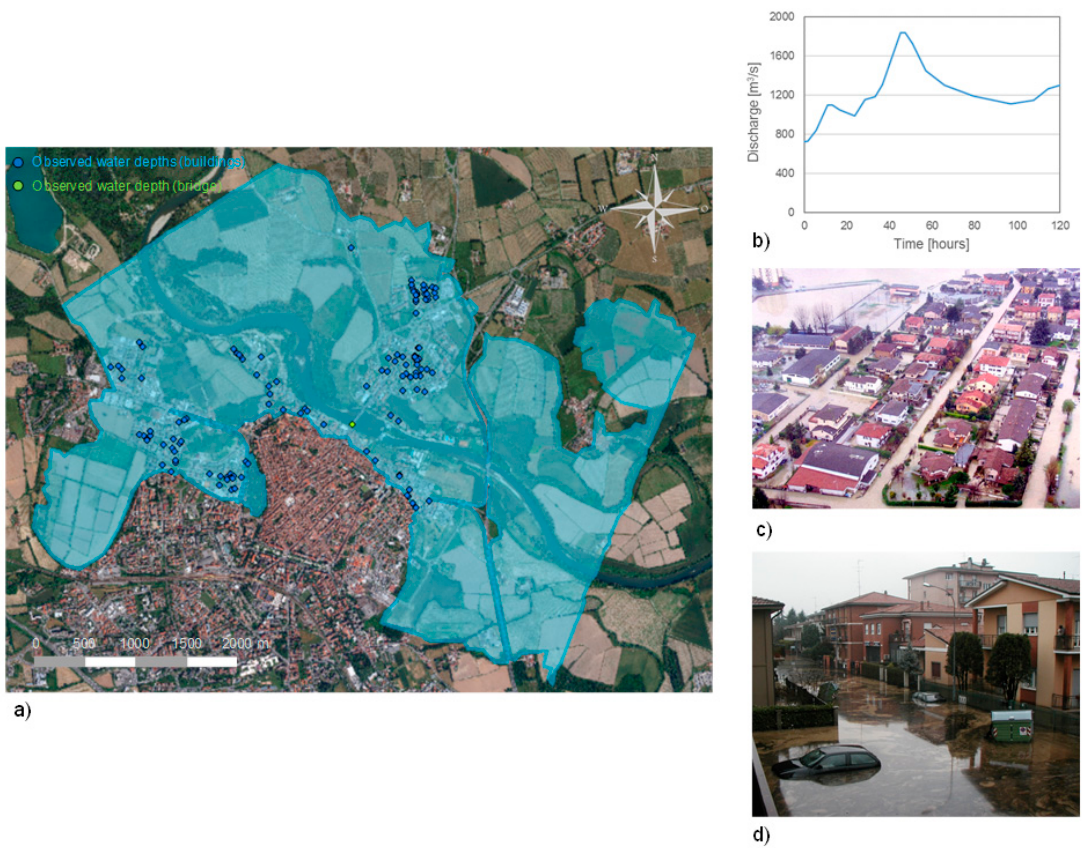
Figure 3. 2002 Adda river flood in the town of Lodi: ( a ) Observed flood footprint and location of observed water depths; ( b ) Observed flood hydrograph at the ancient bridge (the hydrometer is depicted by the green point in panel a); ( c ) Example of available aerial photographs taken during the event; ( d ) Observed oil spill in a part of the inundated area.